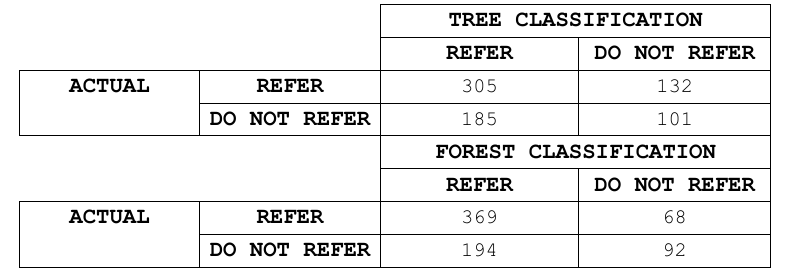
Table 10. Pixel value results.